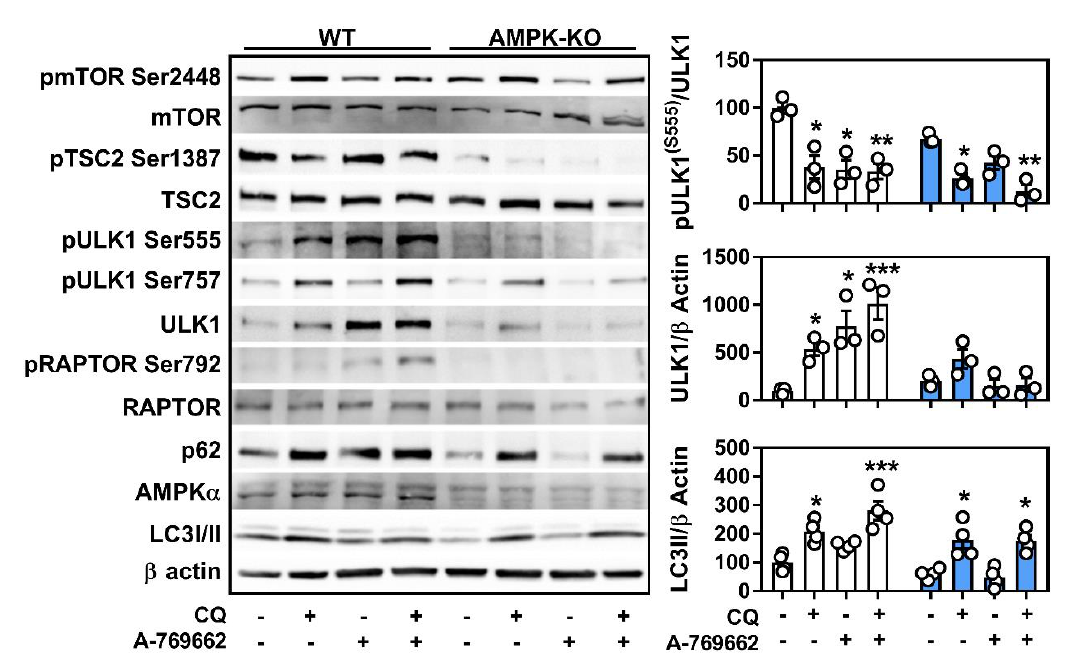
Figure 5. Macrophage AMPK signals through autophagy and is linked to autophagic protein expression. Signaling and flux through autophagy in response to AMPK expression and activation (A-769662 100 µ M) and / or autophagy inhibition (chloroquine 50 µ M) for 5 h. Total and phosphorylated proteins were determined from duplicate gels. Relative quantification for select targets is shown on the right. pmTOR / mTOR (280 kDa), pTSC2 / TSC2 (200 kDa), pULK1 / ULK1 (150 kDa), pRAPTOR / RAPTOR (150 kDa), p62 (62 kDa), AMPK α (60 kDa), LC3I / II (17 / 14 kDa), and β actin (37 kDa). Data are the mean ± SEM and is representative of at least three independent experiments from BMDM isolated from separate mice, where *, ** and *** represent p < 0.05, p < 0.01, and p < 0.001 compared to vehicle control for within genotype.